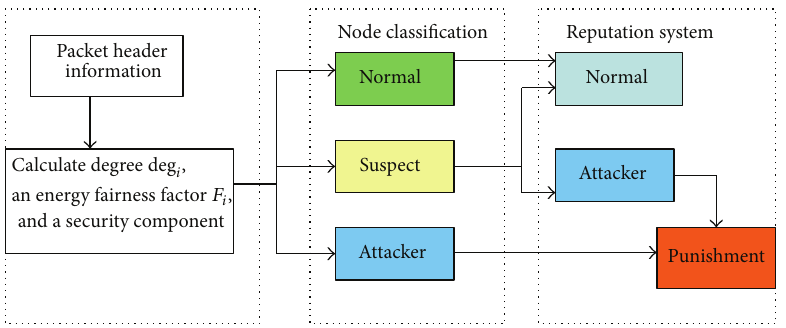
Figure 1: Byzantine agreement classification